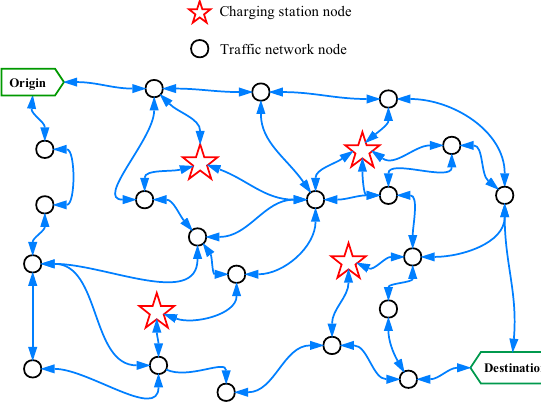
Figure 3. Topology structure of road network model.